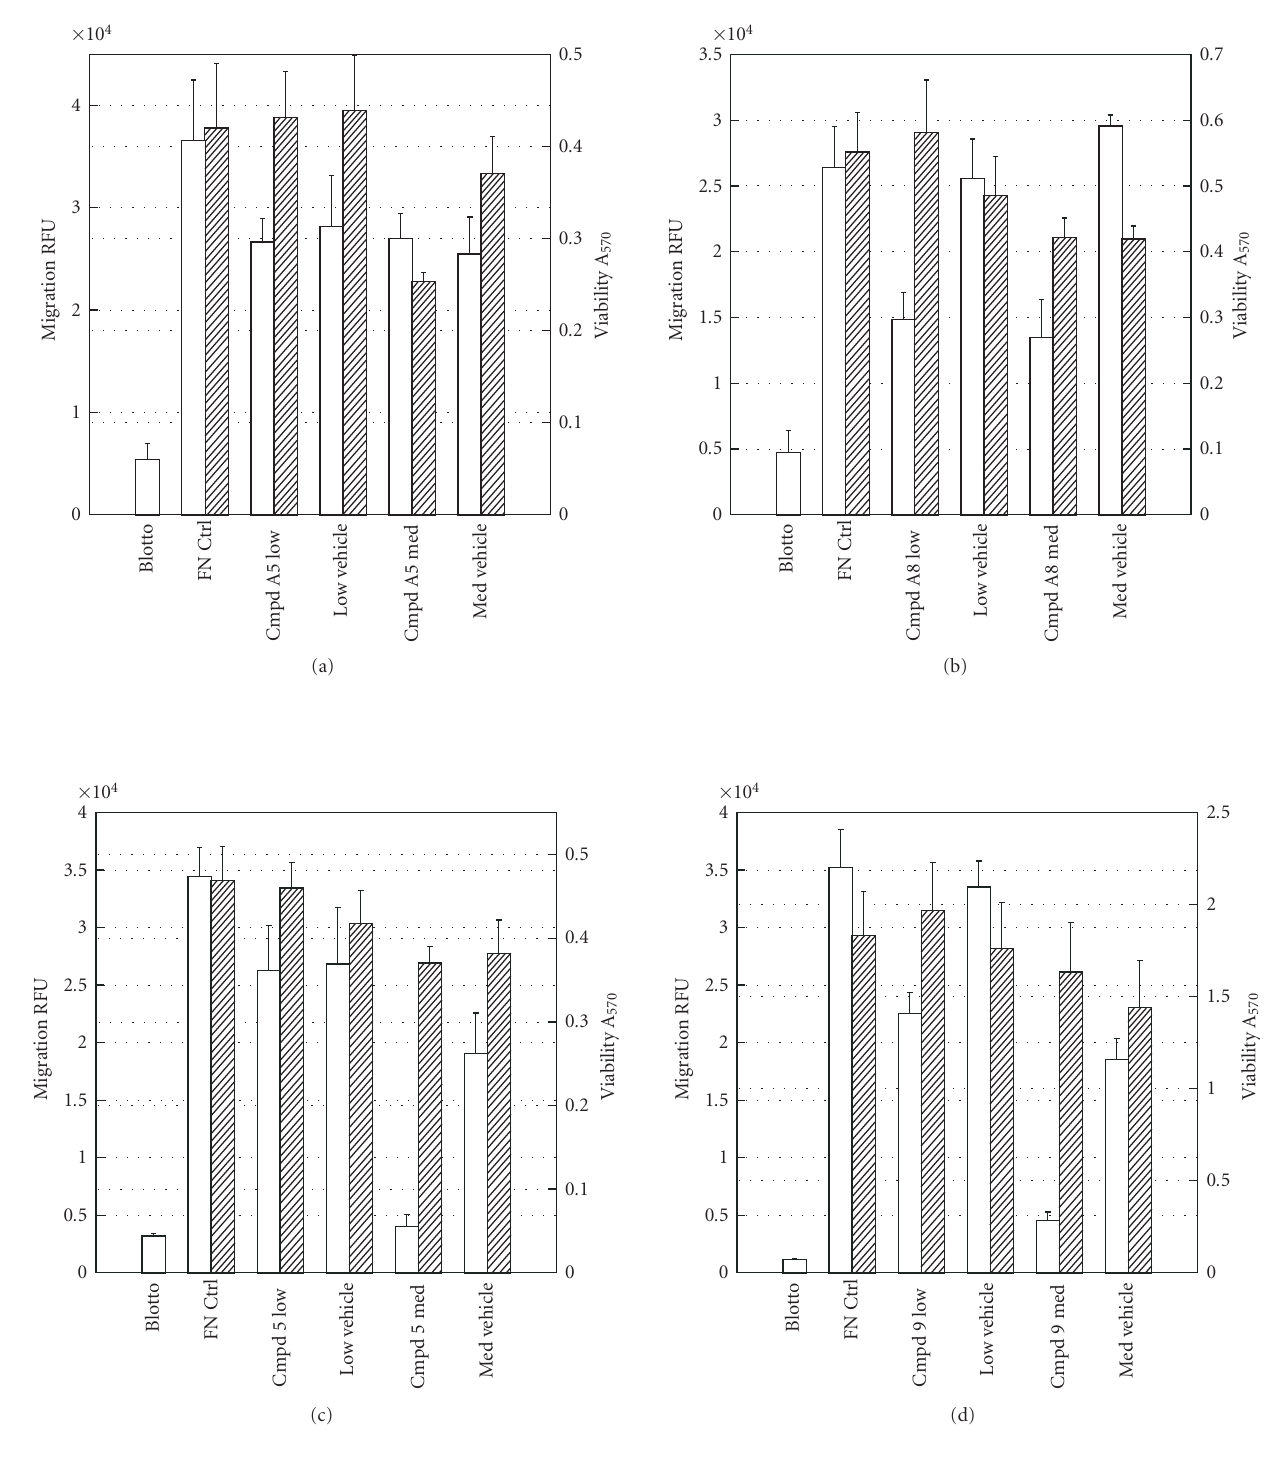
Figure 1: Migration (solid) and viability (shaded) assays of MDA-MB 435 breast cancer cells in the presence or absence of compound A5 (panel (a)), compound A8 (panel (b)), compound 5 (panel (c)), and compound 9 (panel (d)). Migration studies were performed for 18 hours using Millipore MIC plates, and cells were stained with calcein AM. Viability was assessed by utilizing an MTT assay and measuring absorbance at 570 nm. Three concentrations of each compound were used; [low] = 3 . 6ng/ μ L, [med] = 36ng/ μ L, and [high] = 203 ng/ μ l. Data not shown for high